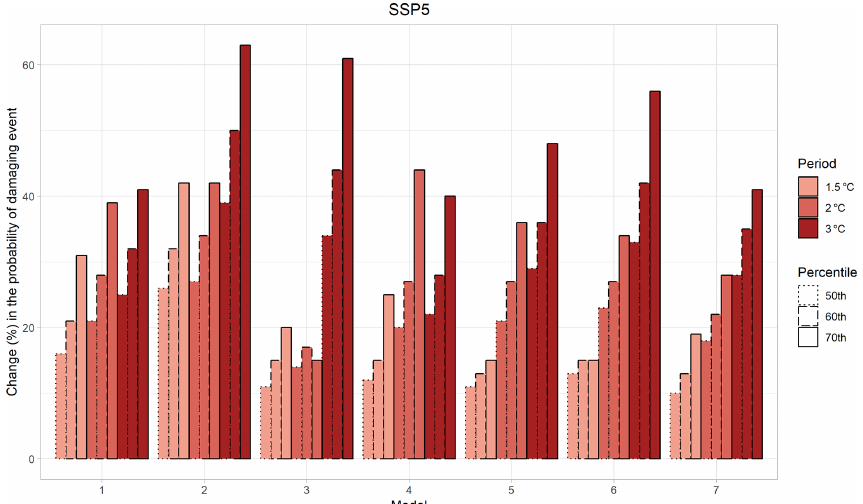
Figure 9. Change in the probability of a damaging event in Catalonia with respect to the reference period (1976–2005) for the 50th, 60th and 70th damage percentiles and for all models when using the SSP5 socioeconomic scenario. Different hatching around bars shows the different percentiles of damage.